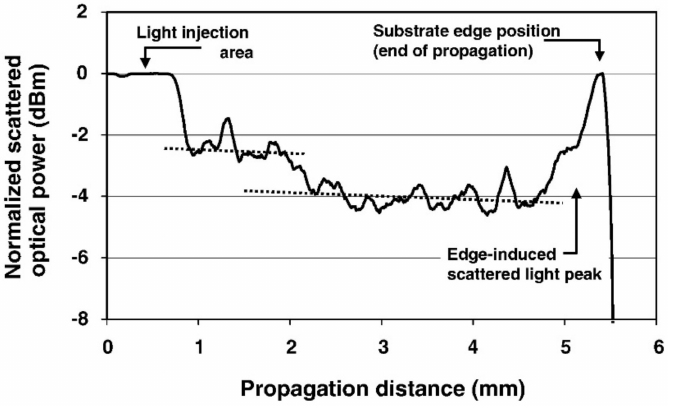
Figure 5. Light injected into a LN thin film grown on sapphire via pulsed laser deposition (PLD) by Kilburger et al. [63,64] shows low propagation losses that indicate a high-quality crystalline